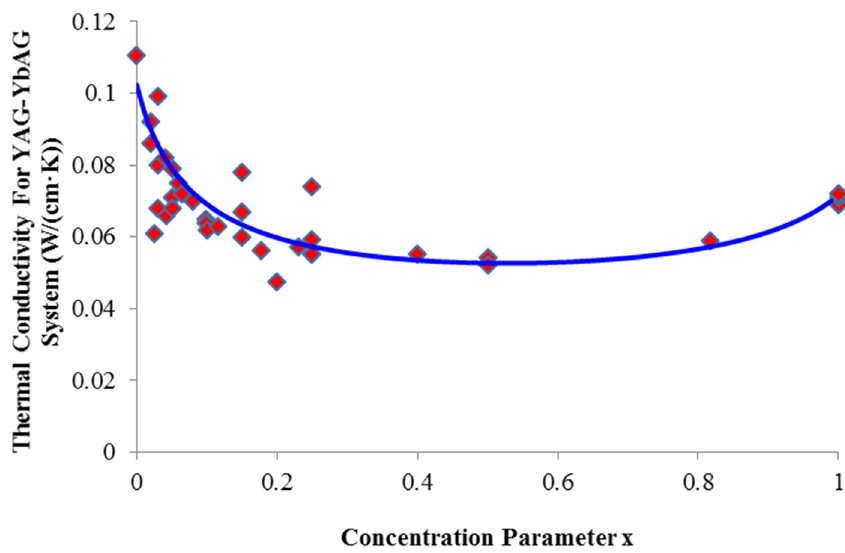
Figure 8. Thermal conductivity calculated using the Klemens model [42] as a function of concentration parameter x for the binary solid solution YAG-YbAG. Data points are taken from the comprehensive summary found in [49].